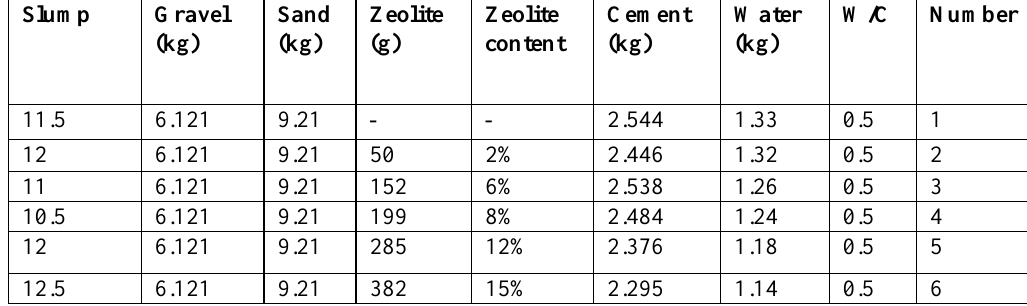
Component values of 320 kg / m 3 concrete mixes studied.